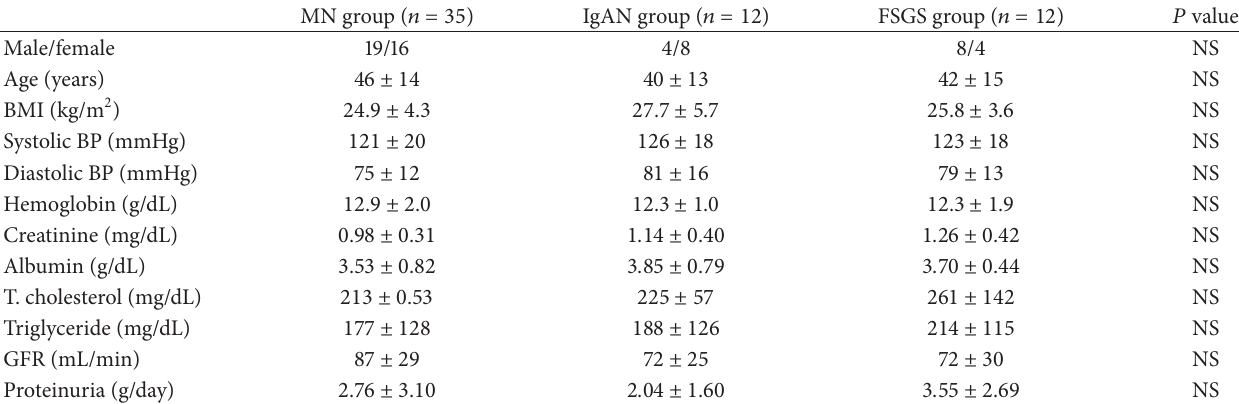
Table 1: The baseline demographic, clinical, and laboratory features of the study